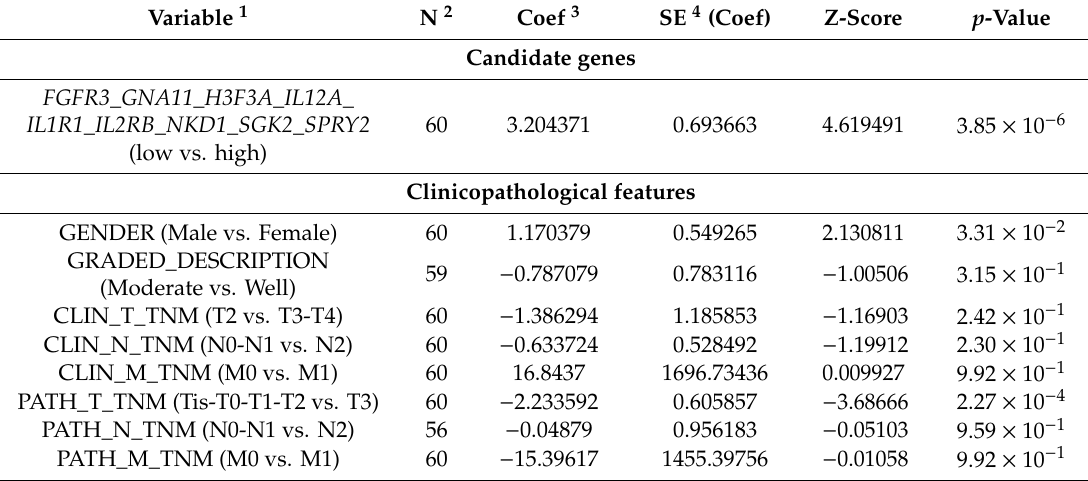
Table 2. Univariate logistic regression analysis of the predictive value of the selected gene signature in preoperative chemoradiotherapy (PCRT) responders ( p < 0.05).